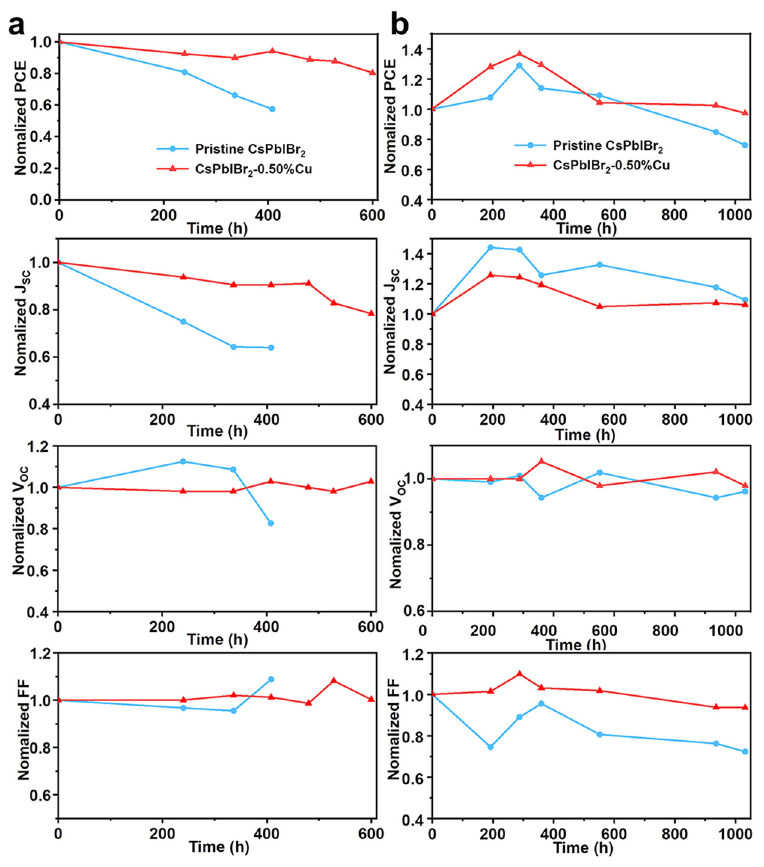
Figure 5. Normalized photovoltaic parameters of CsPbIBr 2 and CsPbIBr 2 -0.50%Cu cells stored in humid air at ( a ) 25 °C and ( b ) 85 °C without encapsulation.